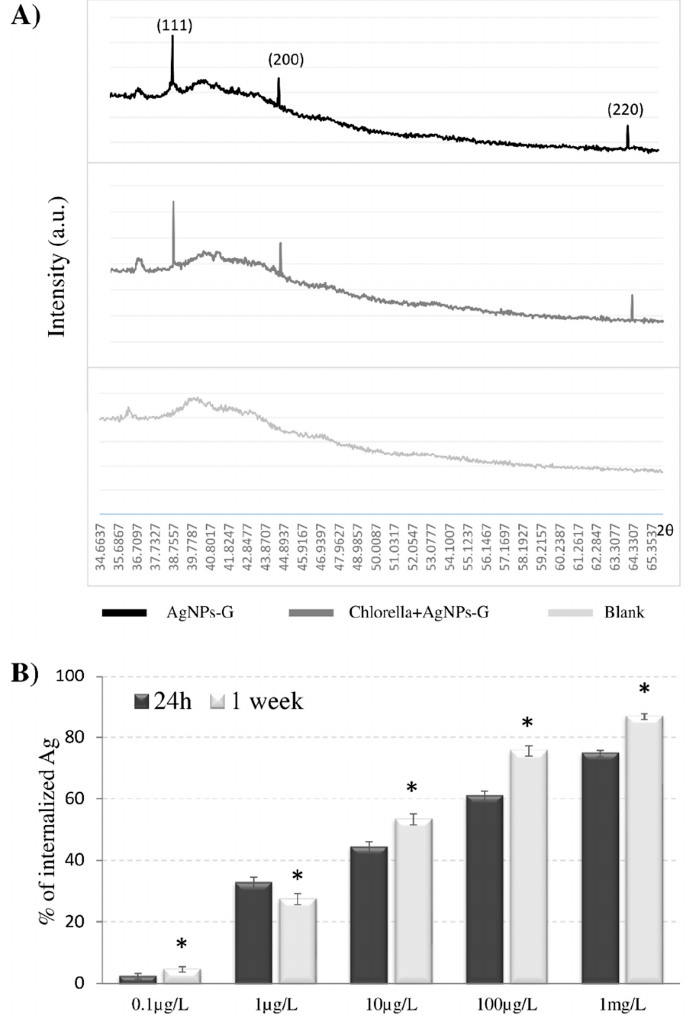
Figure 2. ( A ) X-ray diffraction (XRD) spectrum of AgNPs-G before and after the interaction with